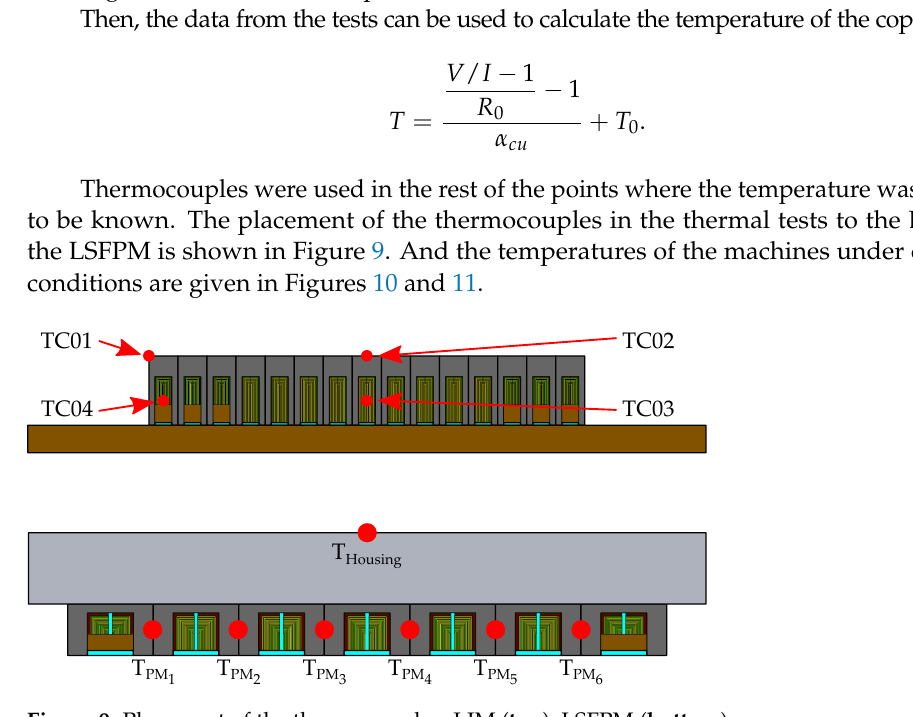
Figure 9. Placement of the thermocouples. LIM ( top ); LSFPM ( bottom